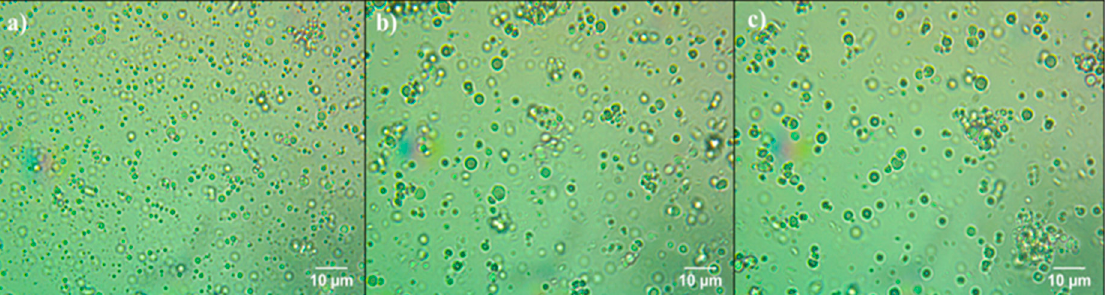
Figure 5. Optical microscopy picture at 100X of ( a ) Pr-E, ( b ) Se-E, and ( c ) Te-E.